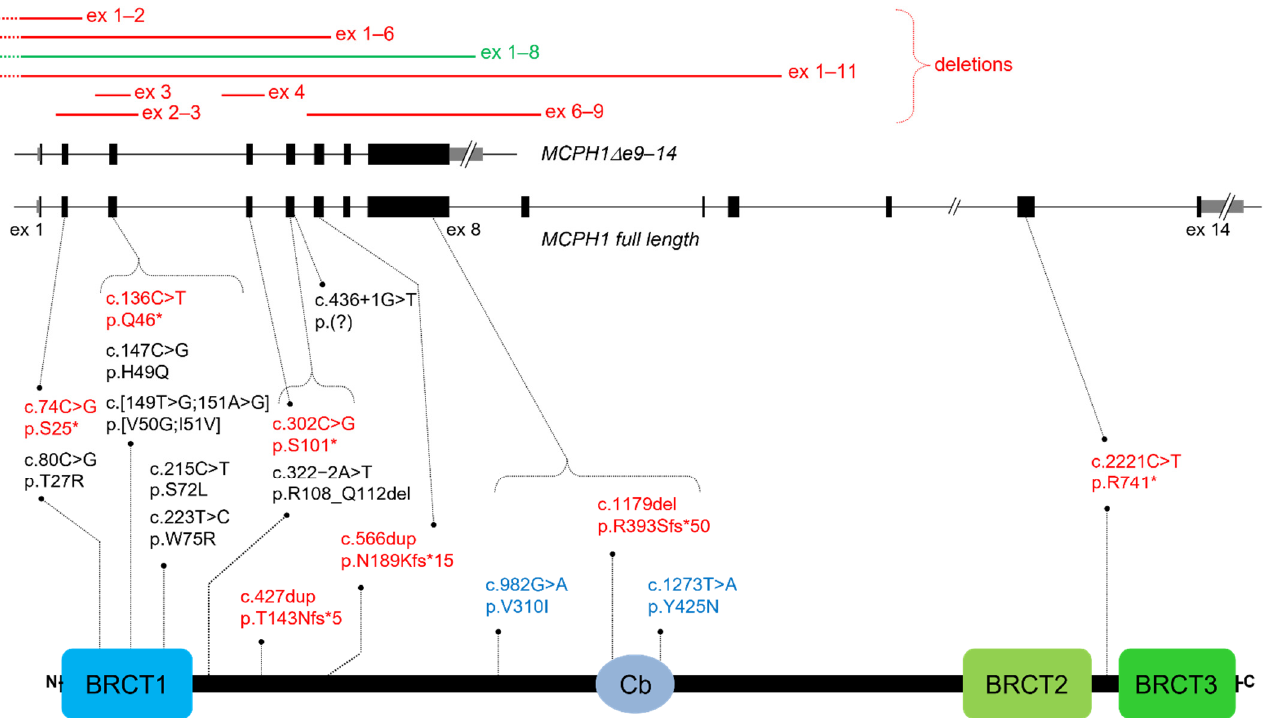
Figure 4. Schematic representation of the two main MCPH1 transcripts and of the full-length protein, on which variants reported in Table S1 have been mapped. ex: exon; gray boxes: UTRs; black boxes: exons; *: stop codon; del: deletion; dup: duplication; BRCT: BRCA1 C ‐ terminal domain; Cb: condensin II binding region; text in red: frameshift/nonsense variants; text in blue: compound heterozygous variants; text in green: deletion identified in our patient.